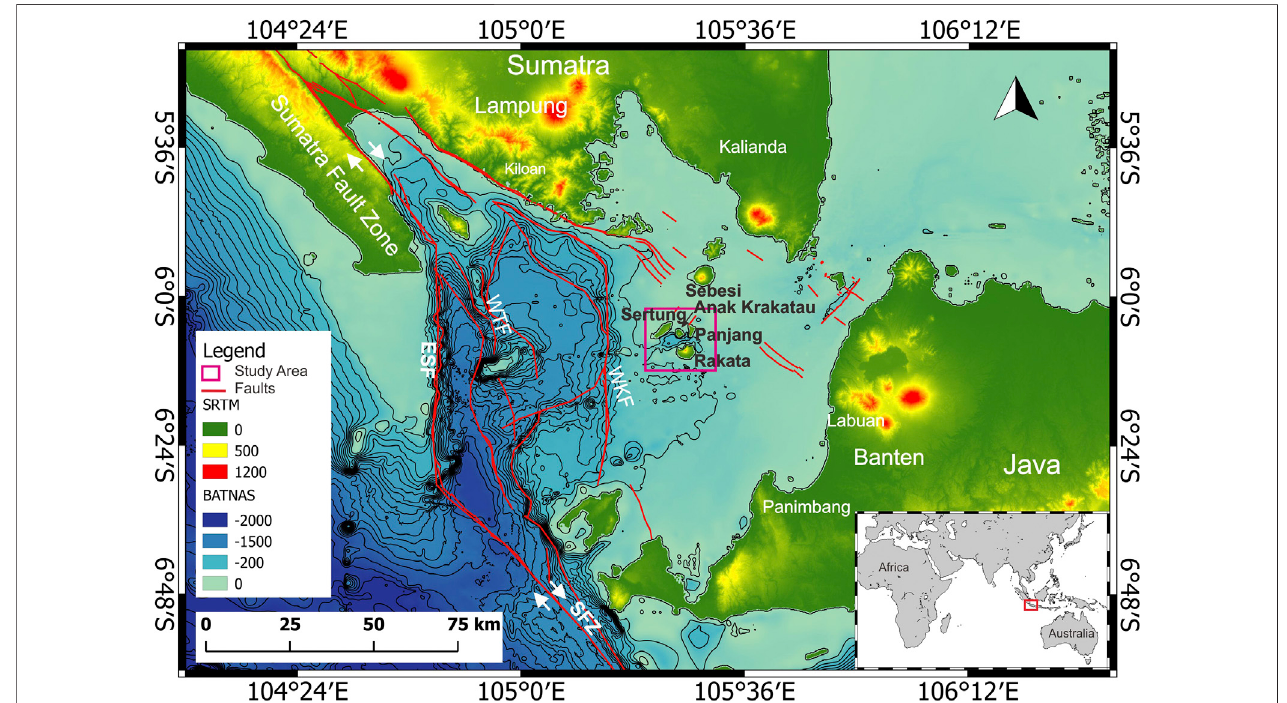
FIGURE 1 | Bathymetric and DEM map of study area setting. Fault name abbreviations: ESF (cid:1) East Tabuan Fault, WTF (cid:1) West Tabuan Fault, WKF (cid:1) West Krakatau Fault, SFZ (cid:1) Sumatran Fault Zone (From BATNAS and DEMNAS, http://tides.big.go.id/DEMNAS/).